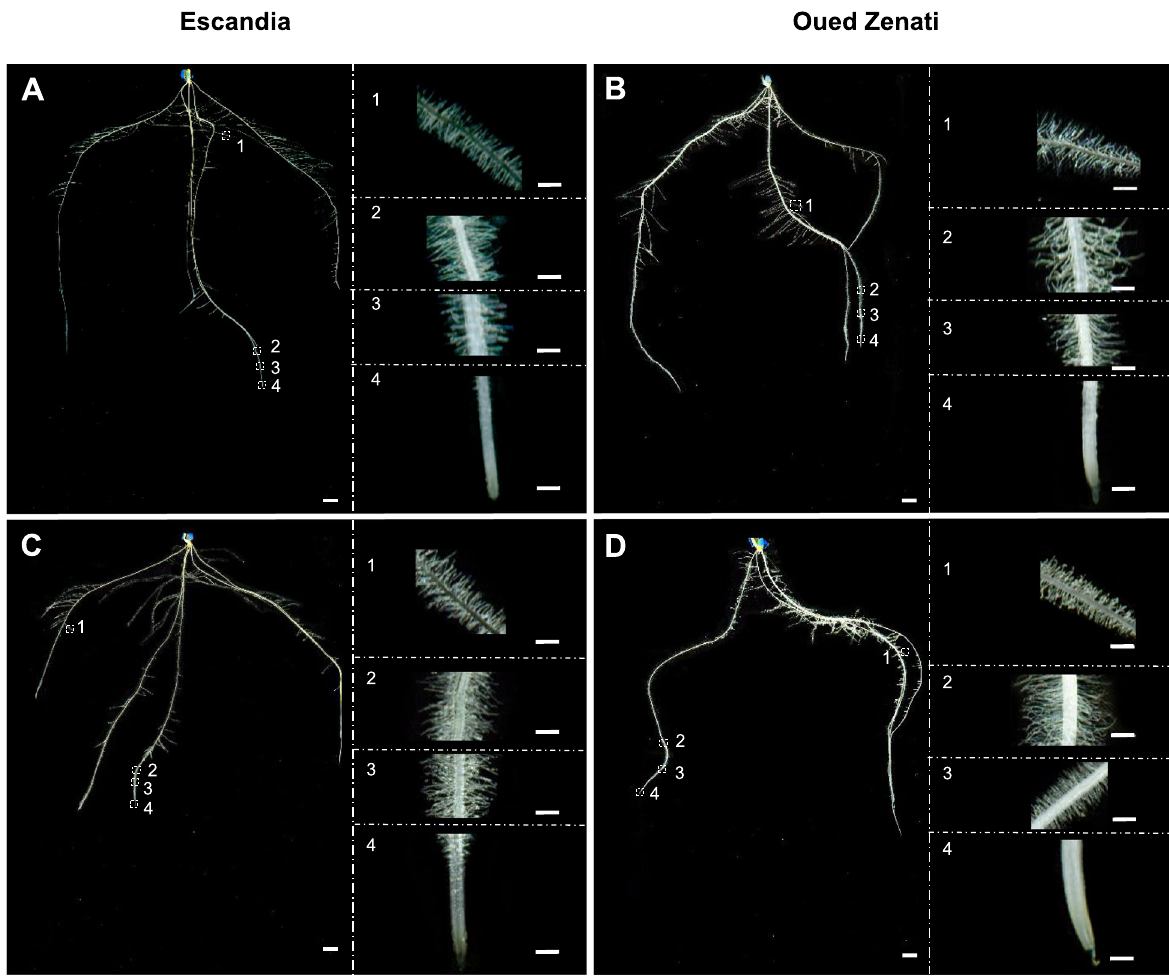
Fig. 4 Representative images of root systems of Escandia and Oued Zenati wheat seedlings grown in the rhizobox‑type device under control or K + shortage conditions. Plants were grown for 14 days in rhizobox devices in control ( A , B ) or K + shortage ( C , D ) conditions (see legends to Figs. 1 and 2). A, C Escandia; B, D Oued Zenati. Insets at right of panels show enlargements of regions from seminal and lateral roots. White bars: 1 cm for the whole root systems, and 1 mm for the